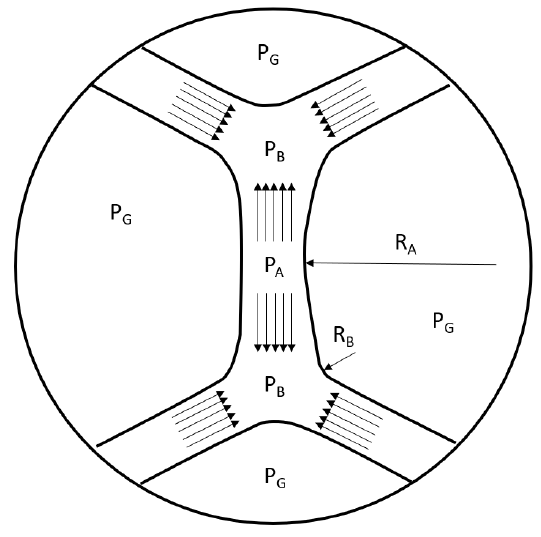
Figure 4. Pressure differences across curved surfaces in a foam lamella (modified from Schramm, [27]).